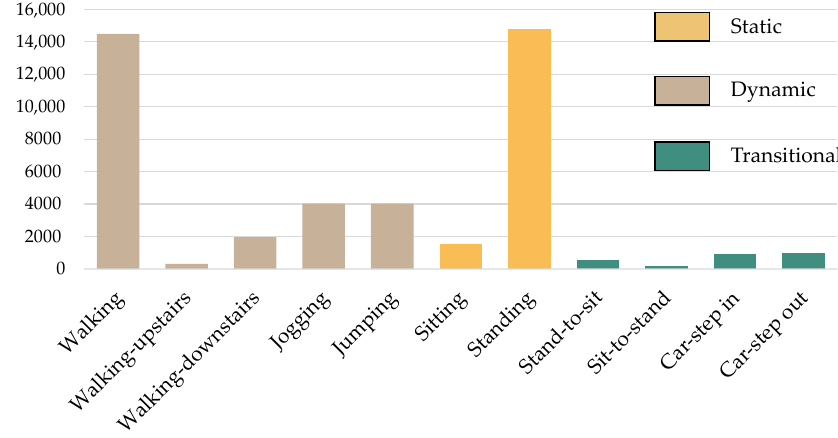
Figure 3. The number of activity samples in the MobiAct v2.0